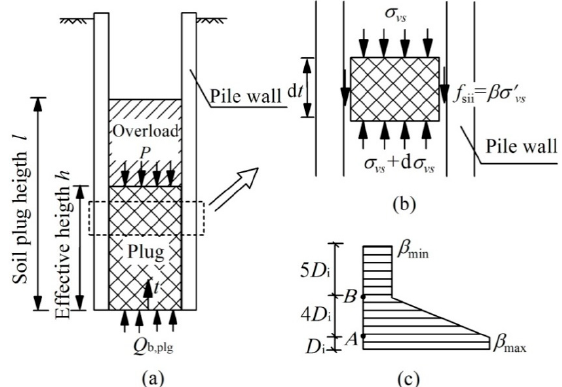
Figure 6. Stress conditions within the soil plug (( a ) equilibrium of soil plug, ( b ) equilibrium of soil plug unit, ( c ) side pressure coefficient model of soil plug ).